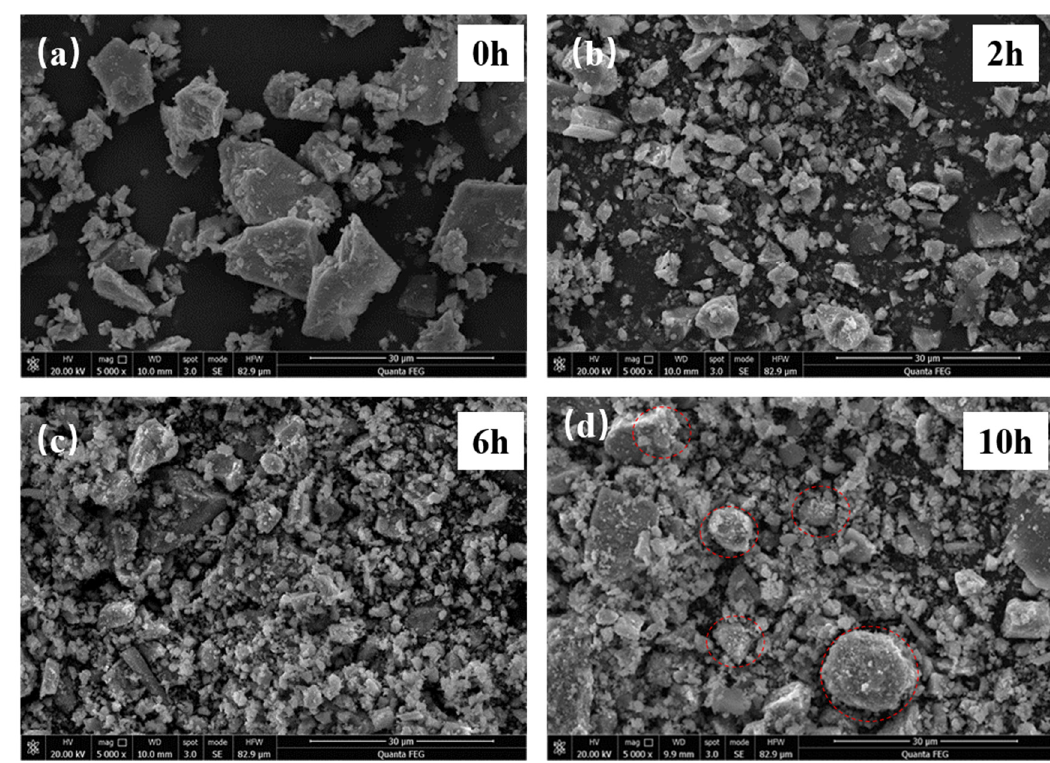
Figure 7. SEM images of the samples milled for different time ( a ) 0 h , ( b ) 2 h, ( c ) 6 h, ( d ) 10 h.